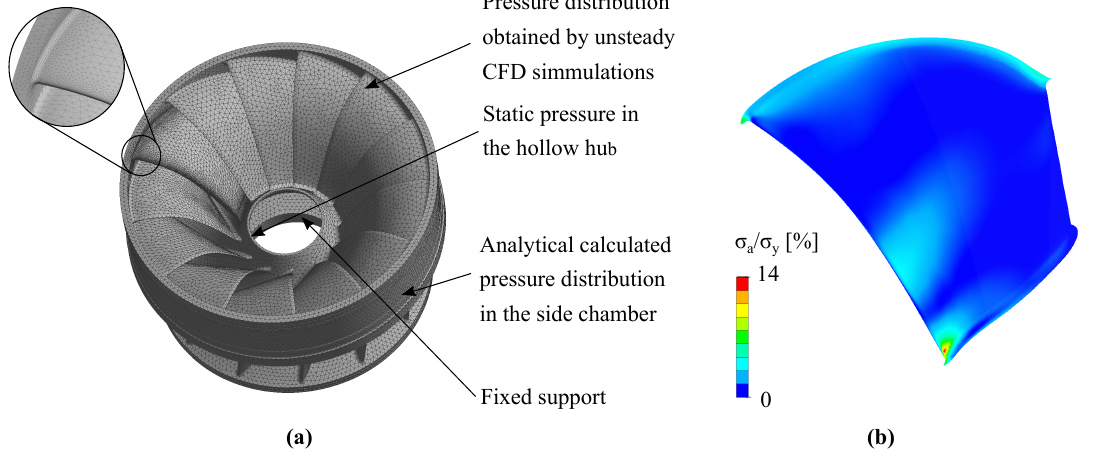
Figure 9. ( a ) setup and ( b ) results of the transient FEM simulation in the critical load region (44% · P RP